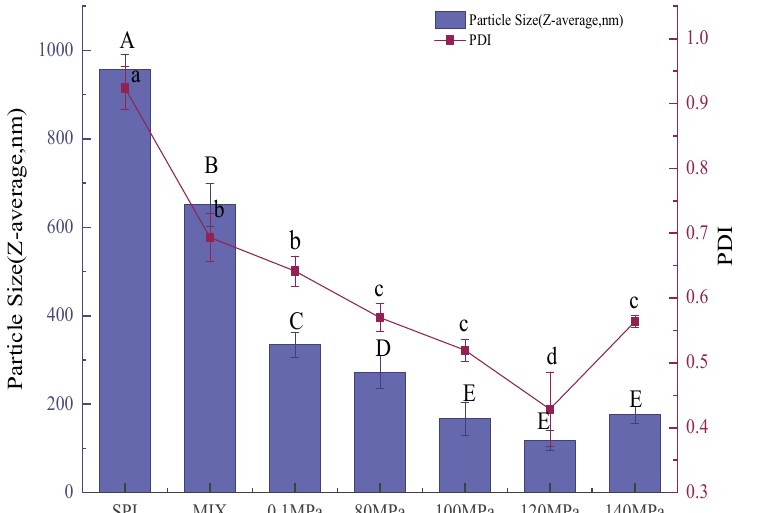
Figure 10. Particle size distribution of emulsions created with the samples. SPI is the native soy protein isolate; MIX represents the mixture of SPI and GOS; 0.1 MPa represents the traditional wet heating Maillard reaction group; 80 MPa, 100 MPa, 120 MPa, and 140 MPa are the HPH treatment groups. The letters a–d and A–E indicate decreasing orders of magnitude ( p < 0.05).